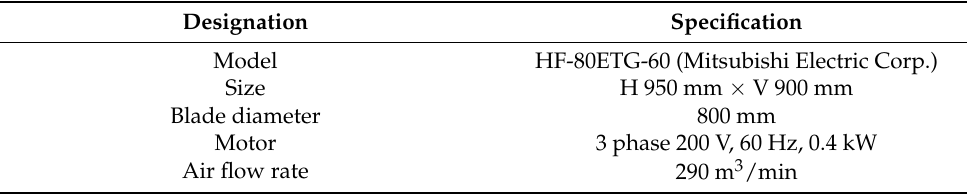
Figure 2. Wind ducts and ventilation fan installed in opposite locations: ( a ) wind duct and additional PVC sheets; ( b ) ventilation fan. Table 1. Specification of ventilation